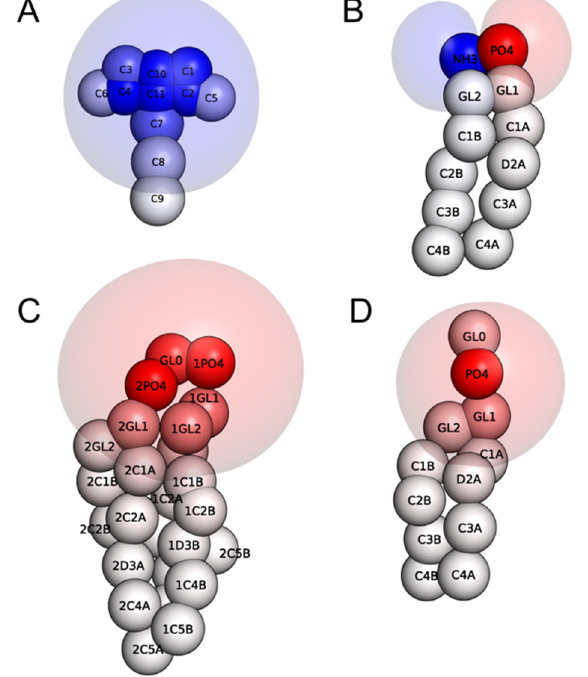
Figure 2. CG spatial structures of NAO and phospholipid components of the model membrane and their equipotential electrostatic surfaces +7 mV (blue), –7 mV (red): NAO ( A ), PE ( B ), CL ( C ), PG ( D ). Colors of CG beads correspond to molecular surface electrostatic potential.